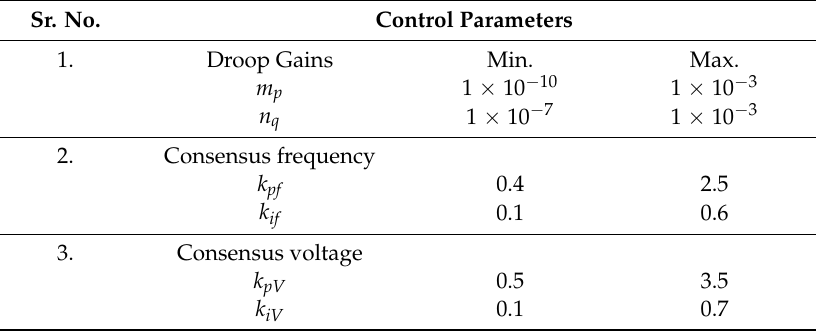
Table 4. Variation range for primary and secondary controller